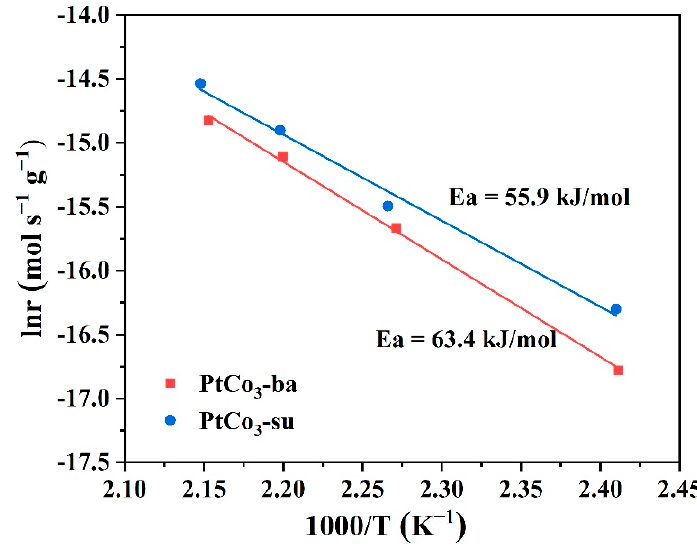
Figure 10. Arrhenius diagram of toluene oxidation on PtCo 3 -ba and PtCo 3 -su.